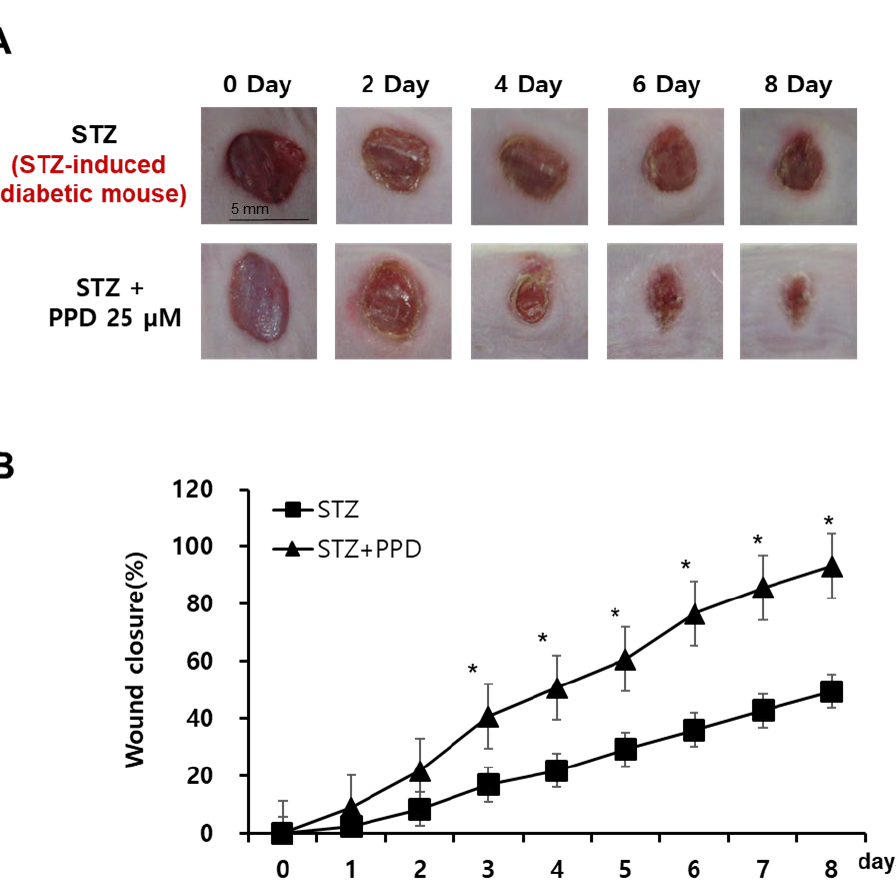
Figure 9. Effect of PPD on wound healing in an experimental mouse model with skin wound. ( A ) Comparison of wound closure between the two groups (mice treated with 25 µ M PPD and those in the control group). Representative pictures of wounds at 0, 2, 4, 6, and 8 days after treatment. Scale bar, 5 mm. ( B ) Quantitative analysis of the wound size in the PPD treatment groups compared to that in the control group. Data are presented as the mean ± standard deviation (SD) of three independent experiments. * p < 0.05 compared to the STZ group.